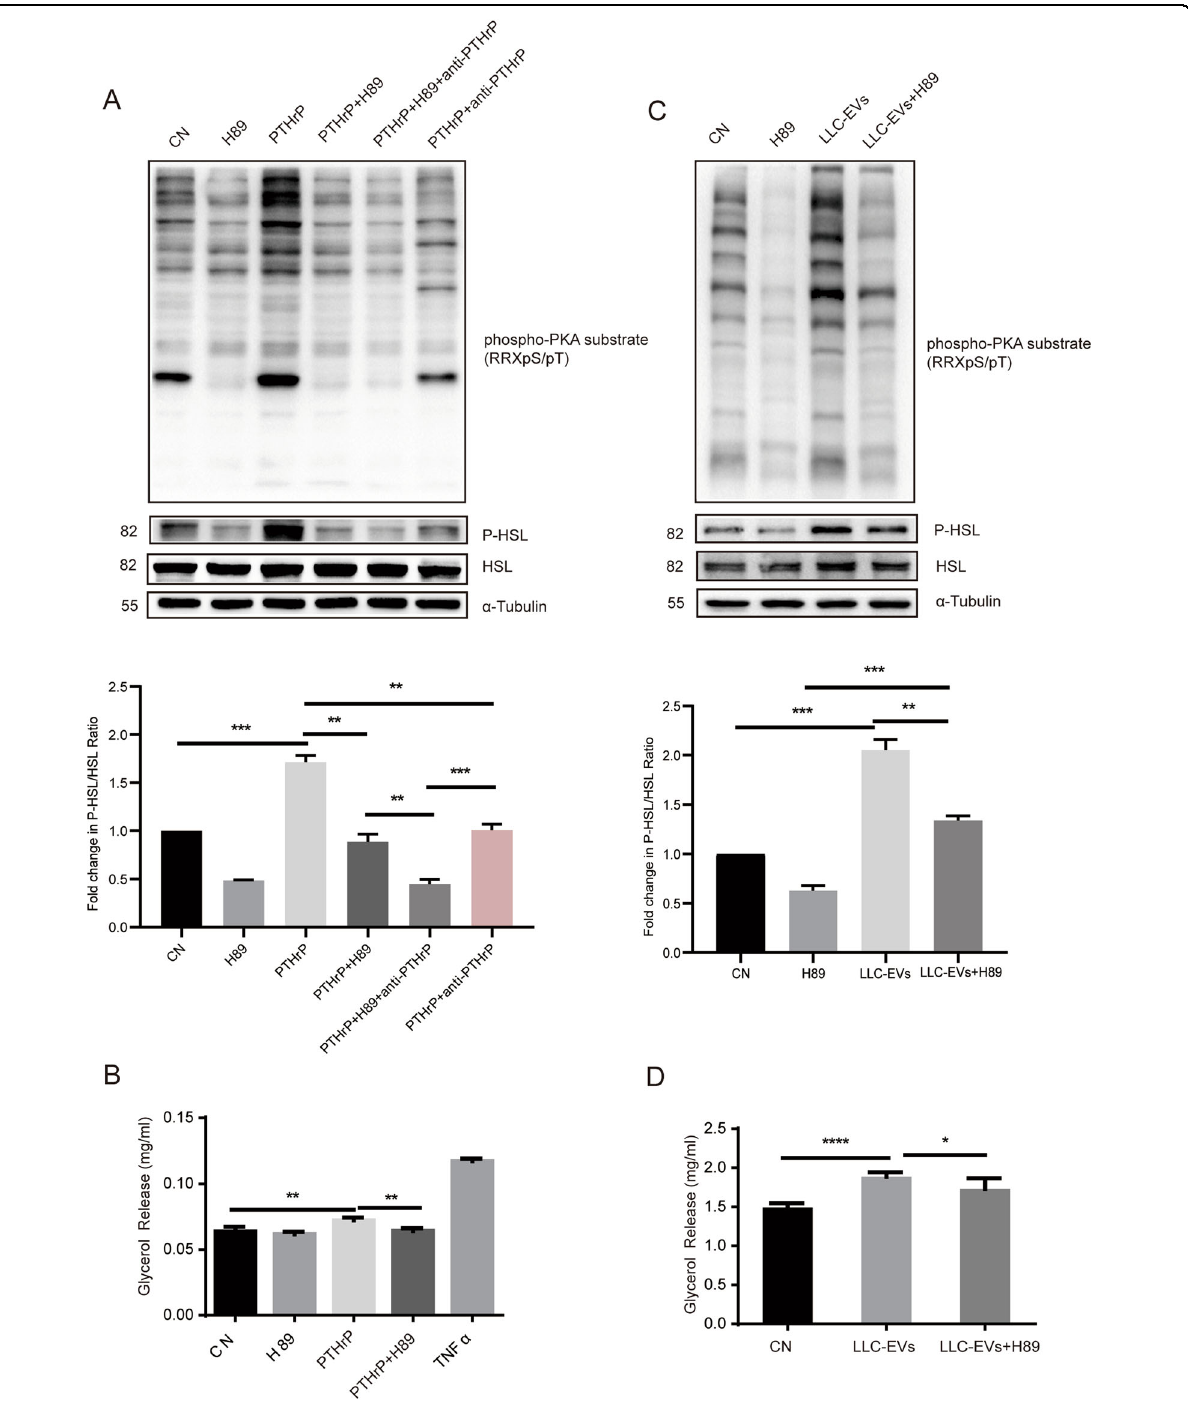
Fig. 5 The lipolytic effect of extracellular PTHrP was mediated through the PKA pathway. 3T3-L1 adipocytes were serum-starved for 2 h and pretreated with 50 μ M H89 for 1 h, then PTHrP (100ng/ml) was added for 30 min to analyze protein phosphorylation by western blotting ( A ) or for 24 h to assess glycerol release ( B ). 3T3-L1 adipocytes were serum-starved for 2 h and pretreated with 50 μ M H89 for 1 h, then LLC-EVs (10 μ g) were added for 30 min to analyze protein phosphorylation by western blotting ( C ) or for 24 h to assess glycerol release ( D ). Data ( n = 3) were analyzed by analysis of variance (ANOVA). *P < 0.05, **P < 0.01, ***P < 0.001, **** P <